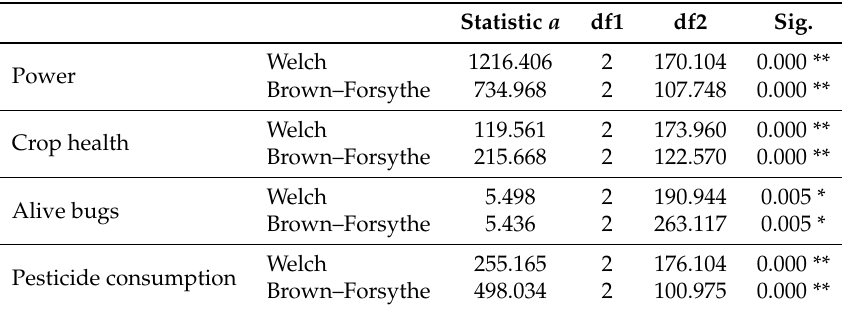
Table 3. Robust tests of equality of means for comparing the three strategies.